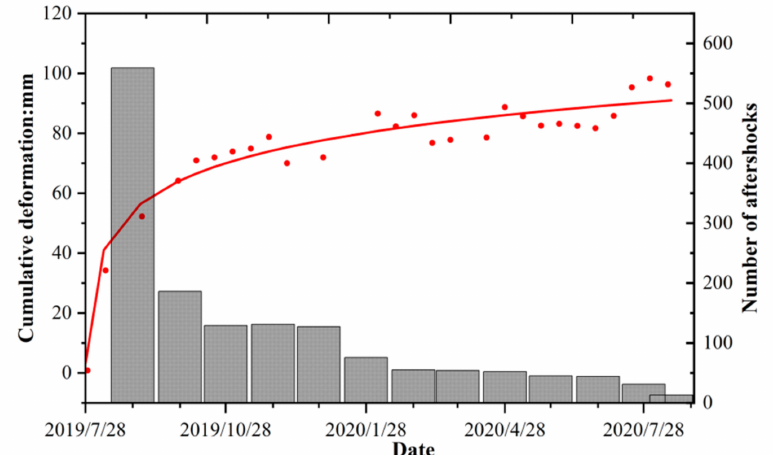
Figure 5. Time series of the cumulative deformation. Red points represent the cumulative deforma- tion time series of the post-seismic. Red line represents fitting line of the post-seismic deformation. X -axis represents date, left Y -axis represents cumulative deformation in LOS, right Y -axis represents number of